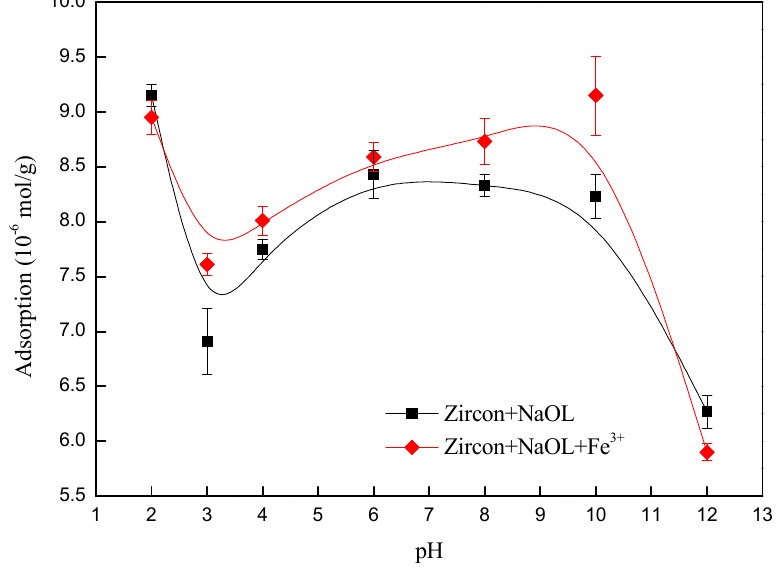
Figure 9. Adsorption of NaOL on zircon as a function of pH with and without Fe 3+ (Fe 3+ : 8 × 10 − 5 mol/L; NaOL: 4 × 10 − 4 mol/L).